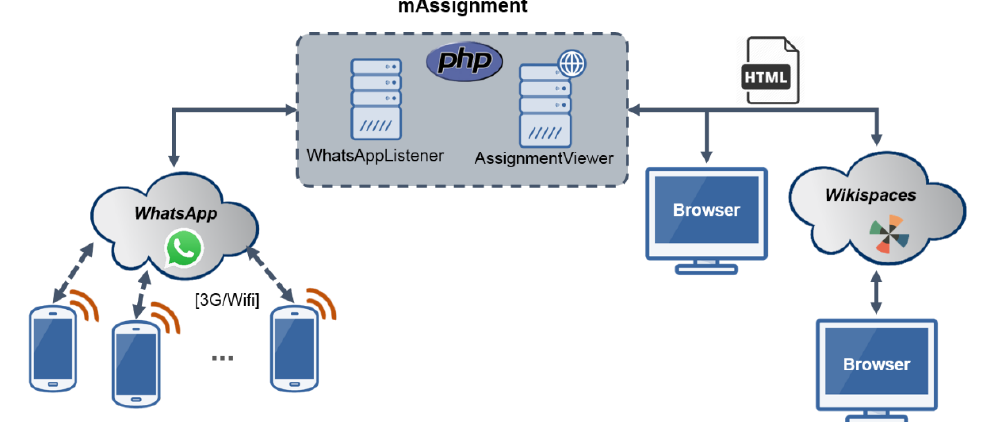
Fig 4. Architecture overview of the mAssignment system